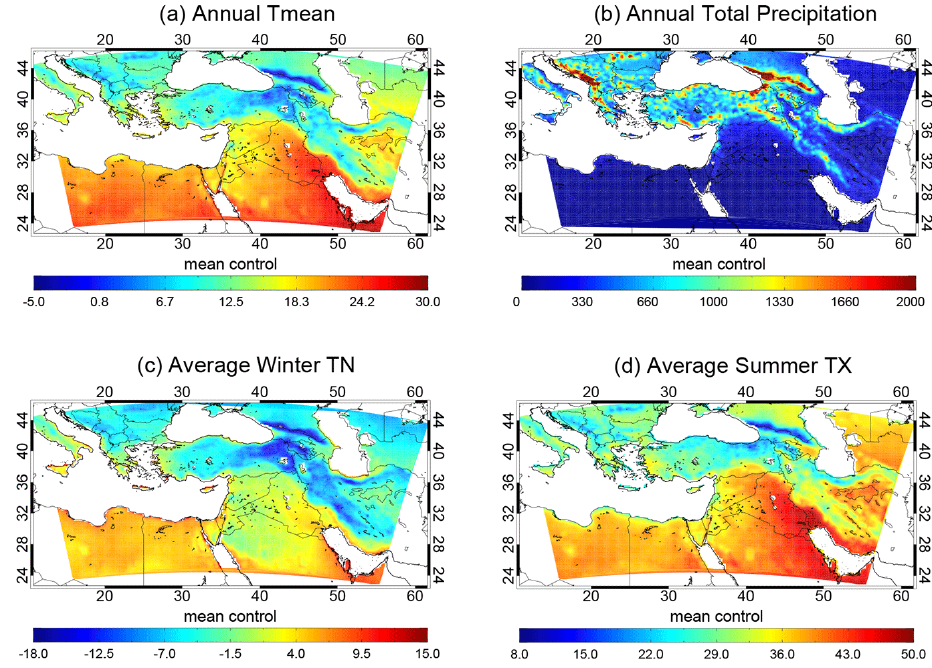
Figure 3. Average annual mean temperature (a) , total annual precipitation (b) , average winter minimum temperature (c) and average summer maximum temperature (d) based on the model control runs for the reference period